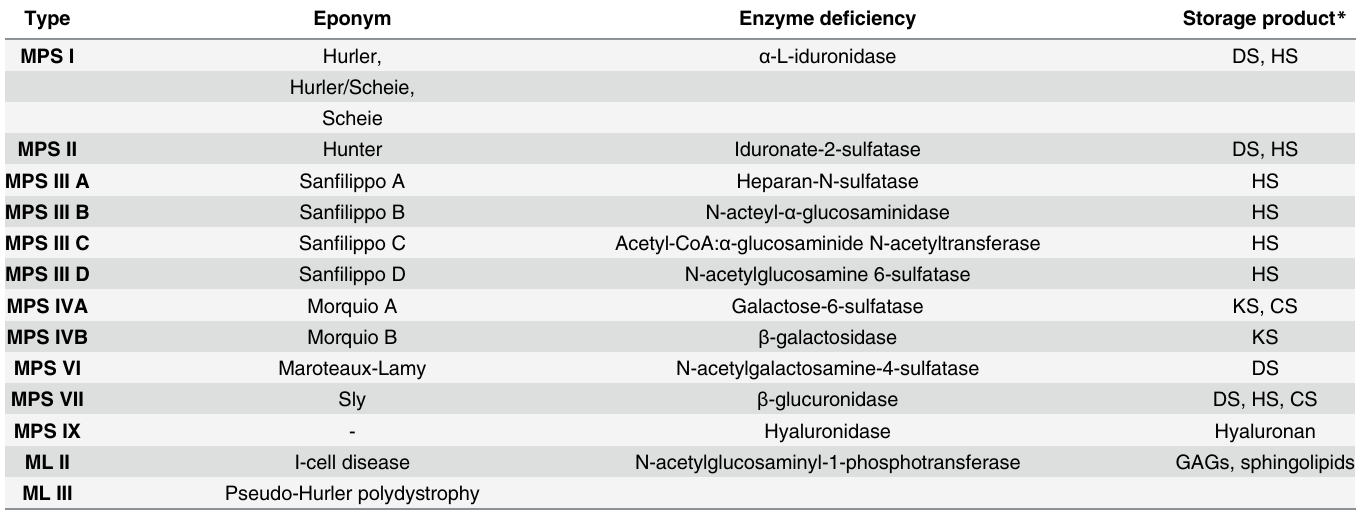
Table 1. The mucopolysaccharidoses and mucolipidosis II and